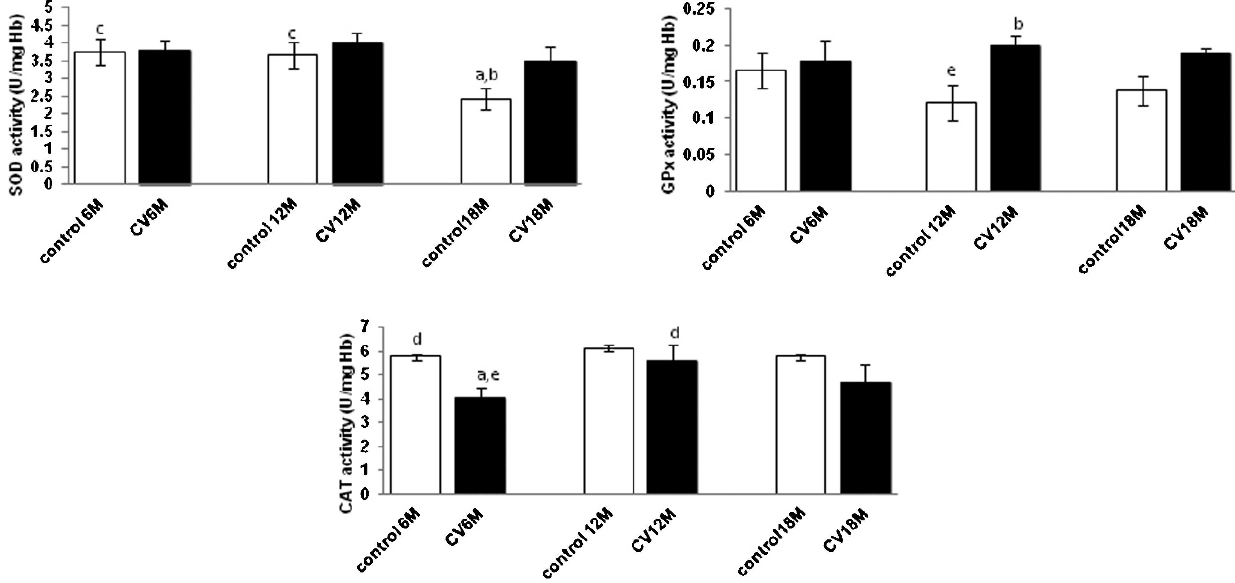
Figure 3 - Effect of Chlorella vulgaris (CV) on erythrocyte SOD, GPx and CAT levels in mice with different ages. Values are the mean ¡ S.E.M. for 8 mice. a-c: significantly different ( p , 0.05) from the control at 6 M, 12 M and 18 M, respectively. d-f: significantly different ( p , 0.05) from CV at 6 M, 12 M, and 18 M,